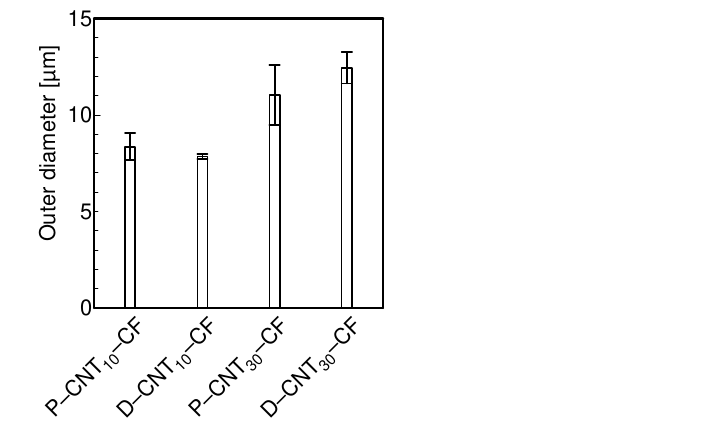
Figure 18. Outer diameter of CNT-grafted carbon fibers (n = 3, mean ± S.D.).